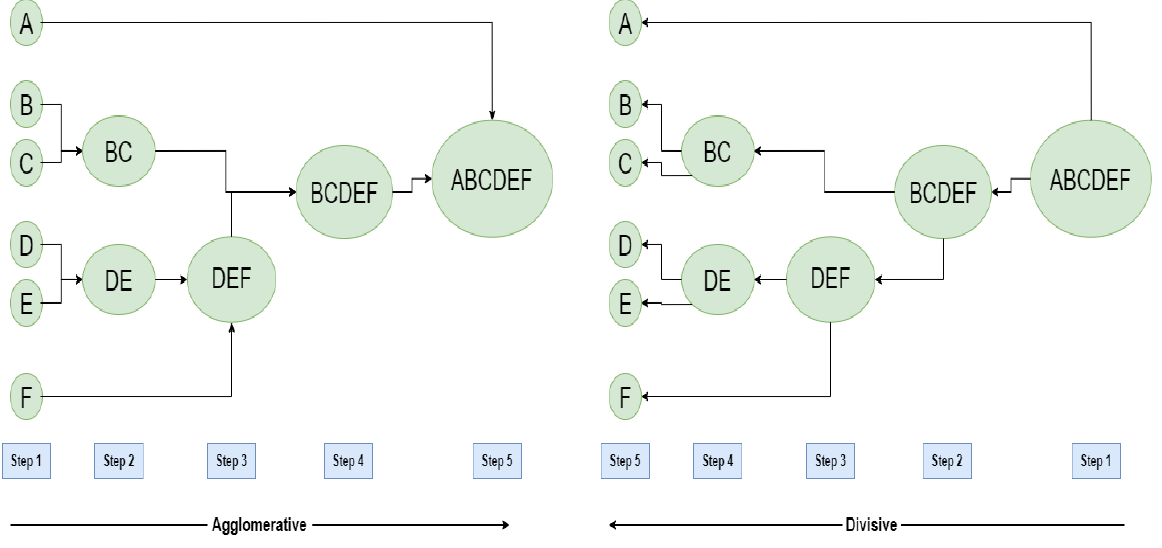
Figure 4. Hierarchical clustering